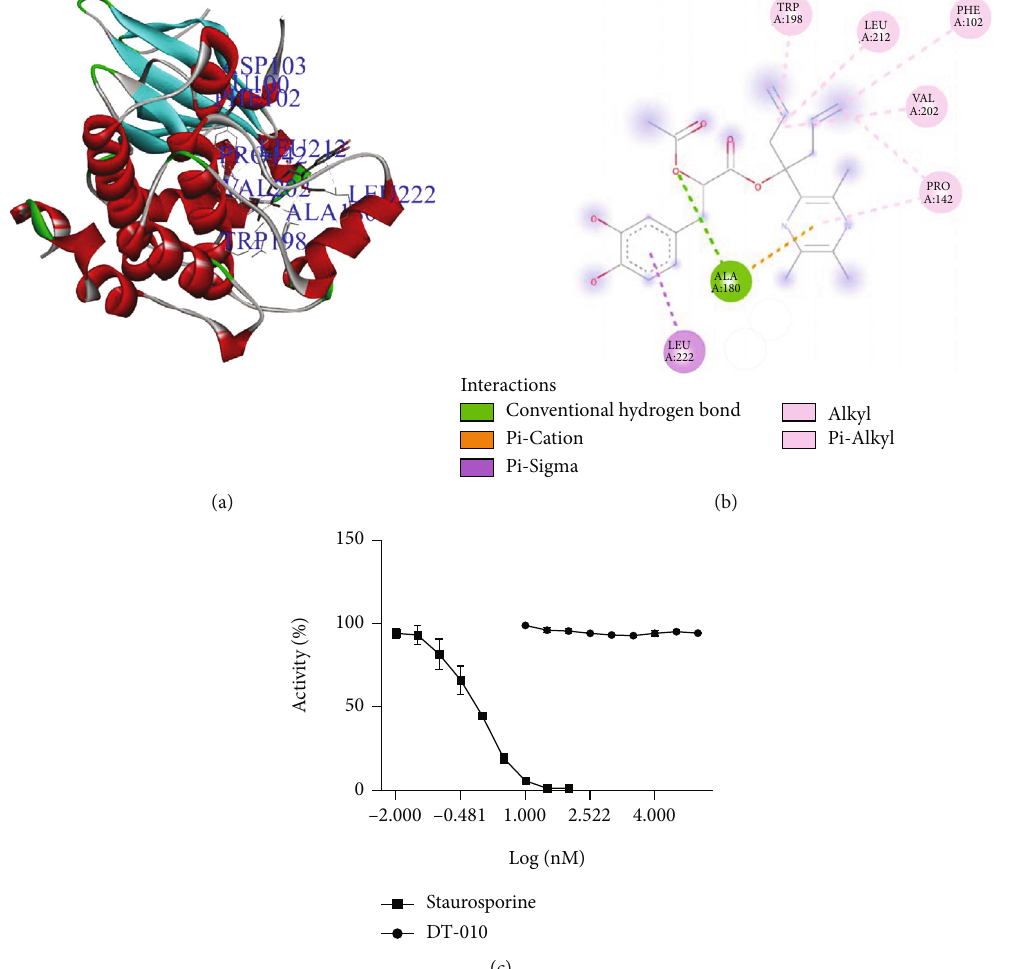
Figure 6: Molecular docking simulation of interaction and AMPK kinase assay. (a) Molecular visualization of the interaction between DT- 010 and the target human protein AMPK. (b) The interaction of amino acid residues in AMPK with DT-010. (c) AMPK activity